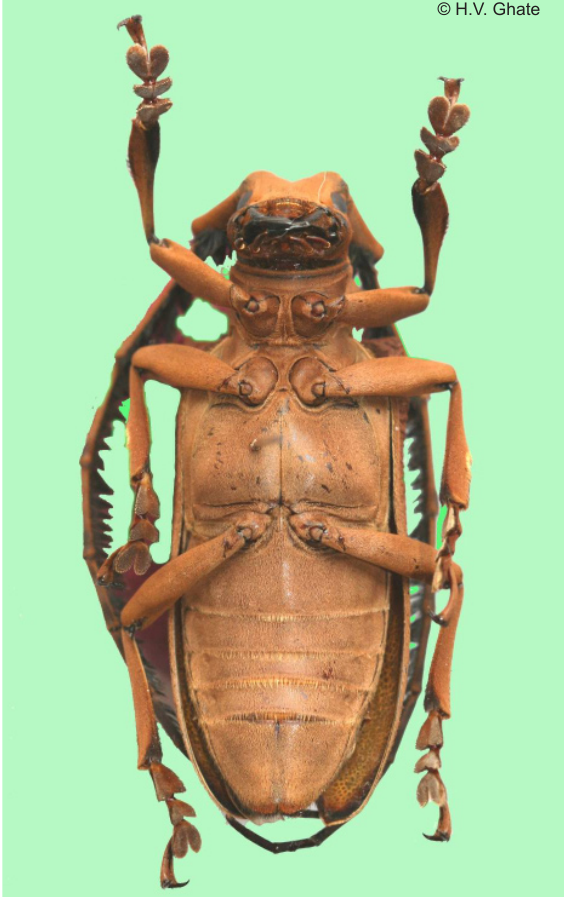
Image 2. Sarothrocera lowii White, ventral